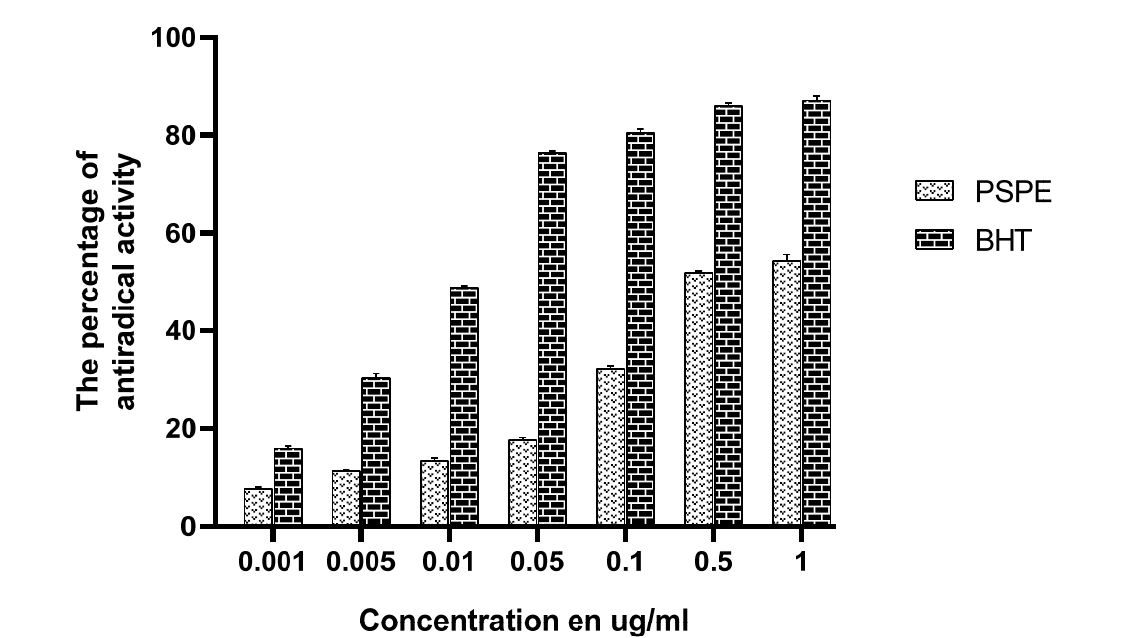
Figure 1. Antioxidant activity of PSPE during the DPPH test. PSPE: Polyphenolic fraction of P. sativum , BHT: Butylated hydroxytoluene.